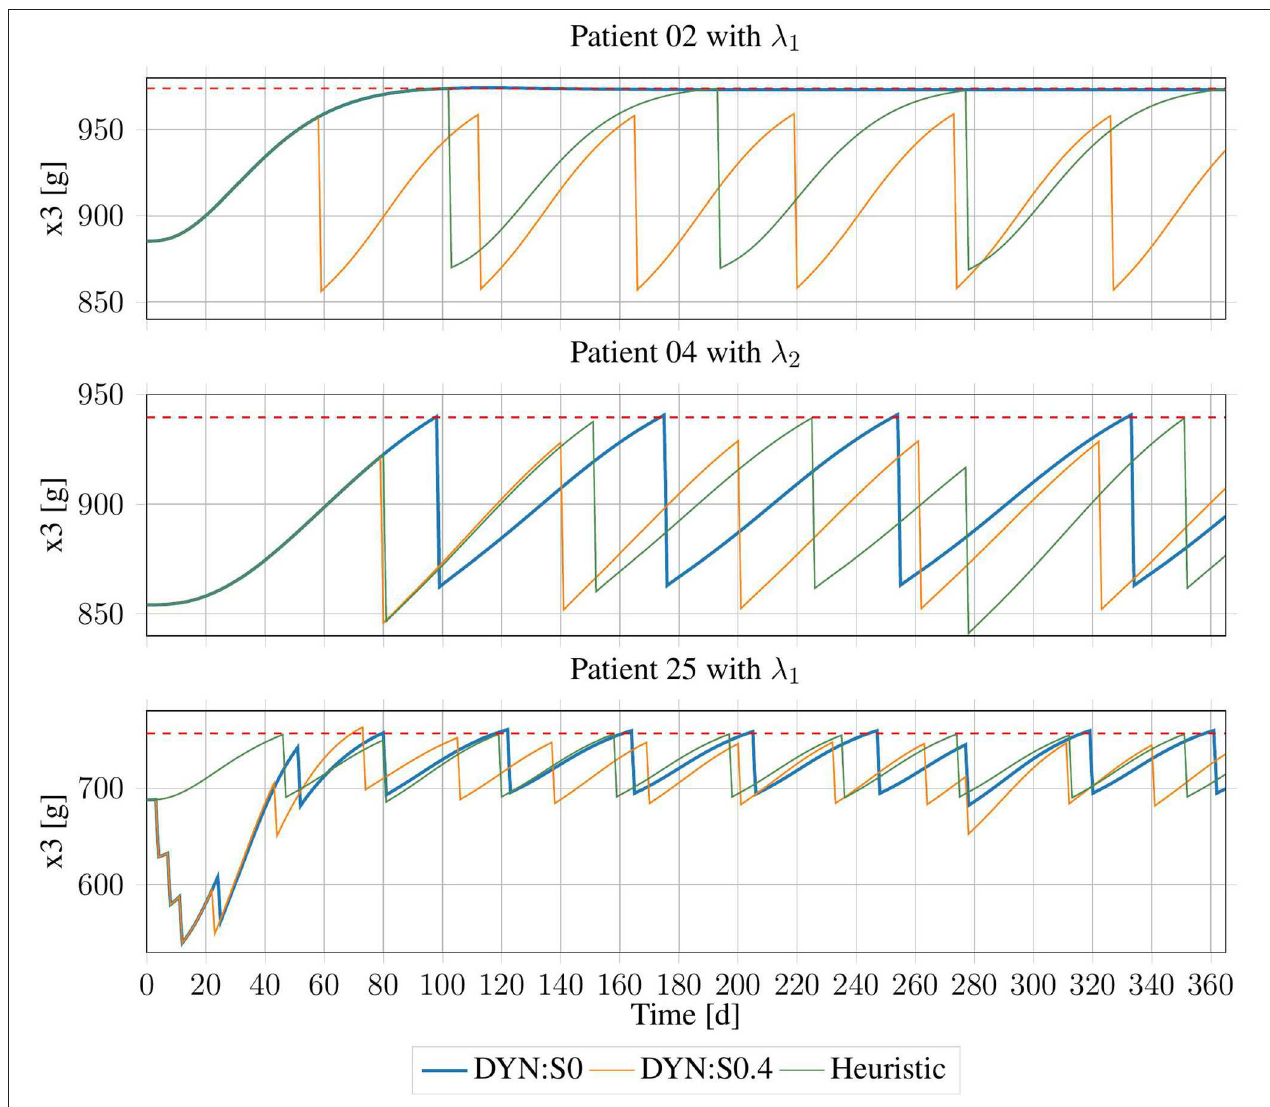
FIGURE 7 | Erythrocyte trajectories using DP-Schedules for both rounding approaches and HC-Schedules for three exemplary patients. X 3,up is shown as the red dashed